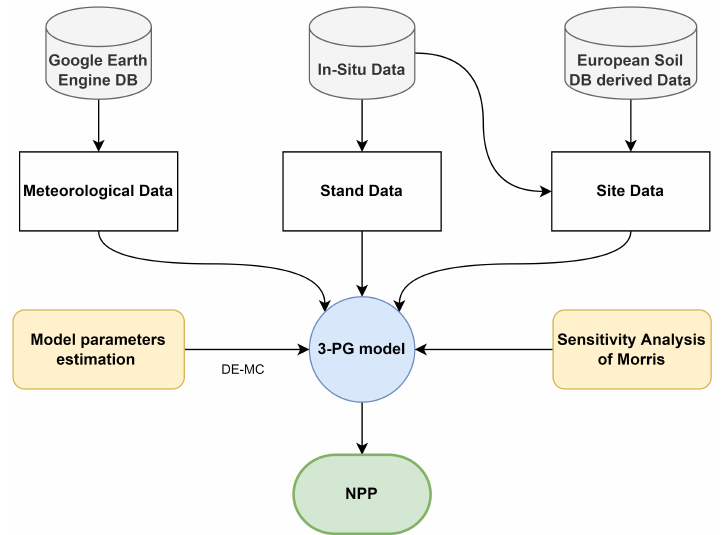
Figure 2. Flowchart of the global